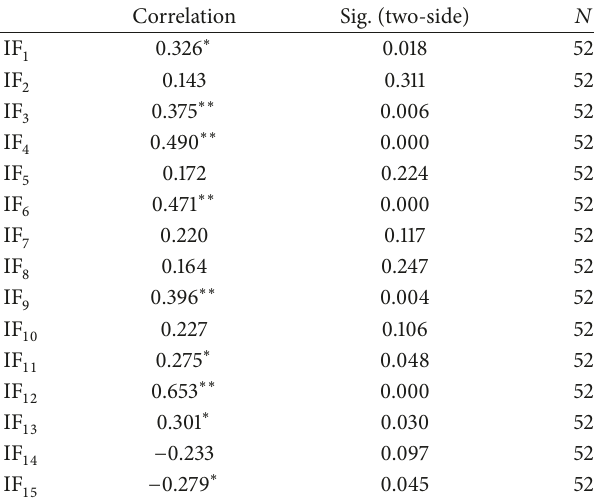
Table 6: Influencing factors quantitative analysis